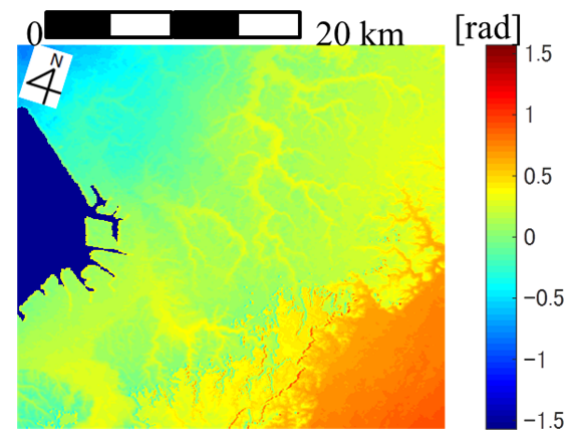
Figure 6. Estimated ZWD ´ phase for the interferogram of images 0 and